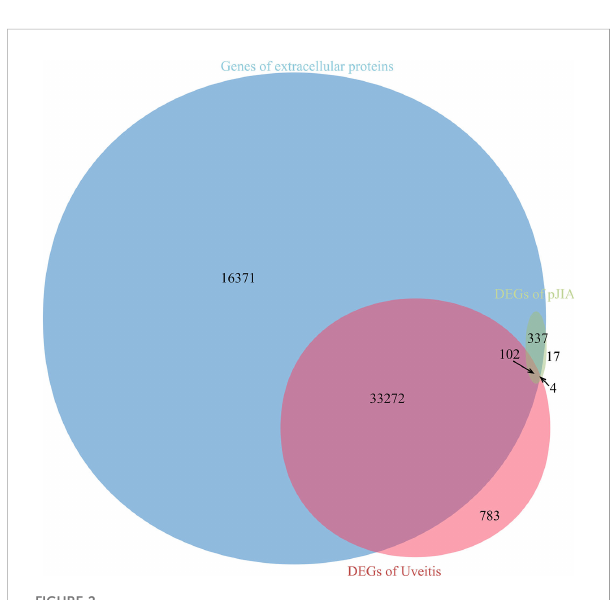
FIGURE 2 Relationship between differentially expressed genes and genes encoding extracellular proteins.